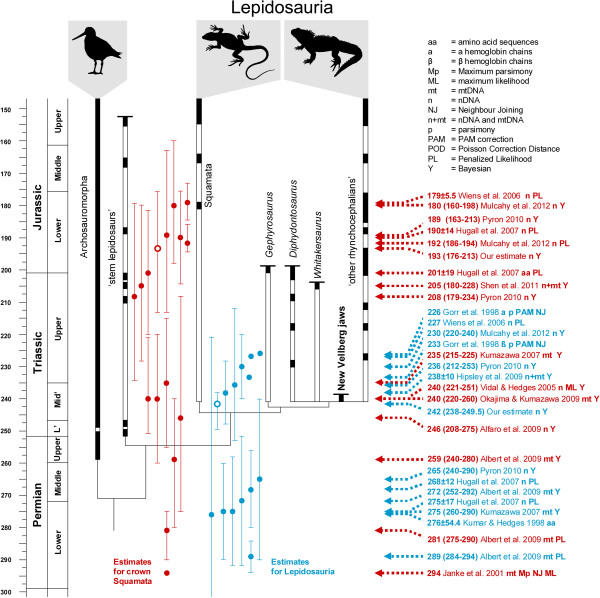
The phylogenetic relationships and fossil record of early lepidosaurs compared to molecular divergence estimates. Estimates for the origin of Lepidosauria based on previous molecular studies are listed on the right in blue with short arrows. Estimates for the origin of crown group Squamata are listed on the right in red with long arrows. Timescale based on Gradstein et al. [47]. Fossil records include those described, or referred to, in Butler et al. [105], Carroll [27], Clark and Hernandez [31], Colbert [30], Evans [8,9,26,33,91], Evans and Białynicka [34], Evans and Jones [5], Evans et al., [18], Fraser [22,23,136], Fraser and Benton [11], Heckert et al. [24], Nesbitt [180], Renesto [137], Reynoso [19,150], Robinson [29], Sues and Hopson [13], Sues and Olsen [12], Whiteside [15], and others listed in Evans et al. [181] and Jones et al. [10].